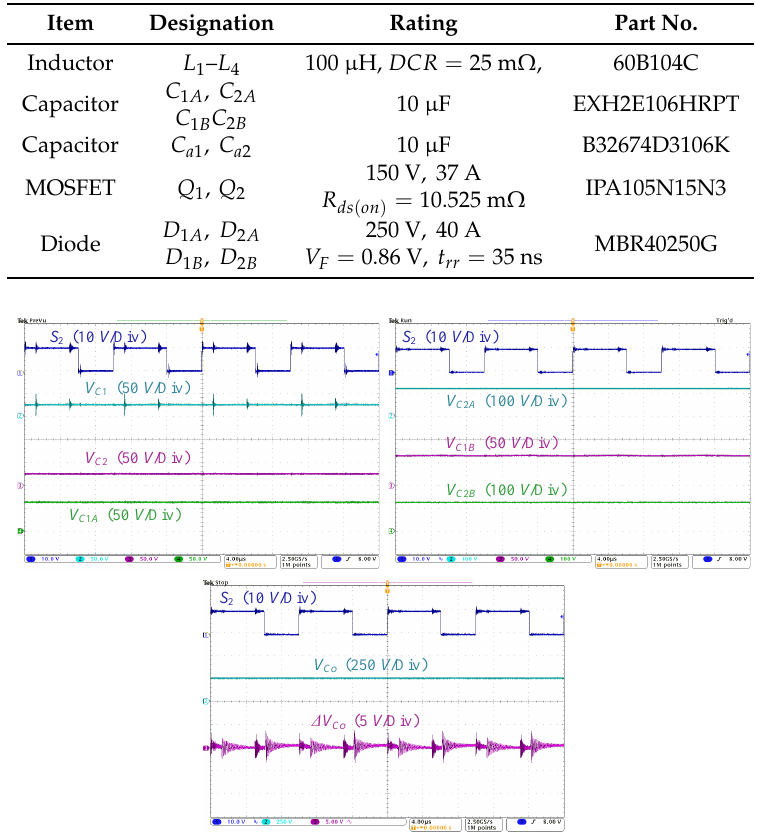
Figure 11. Voltage waveforms of the capacitors, the output load and the ac components of the output voltage.